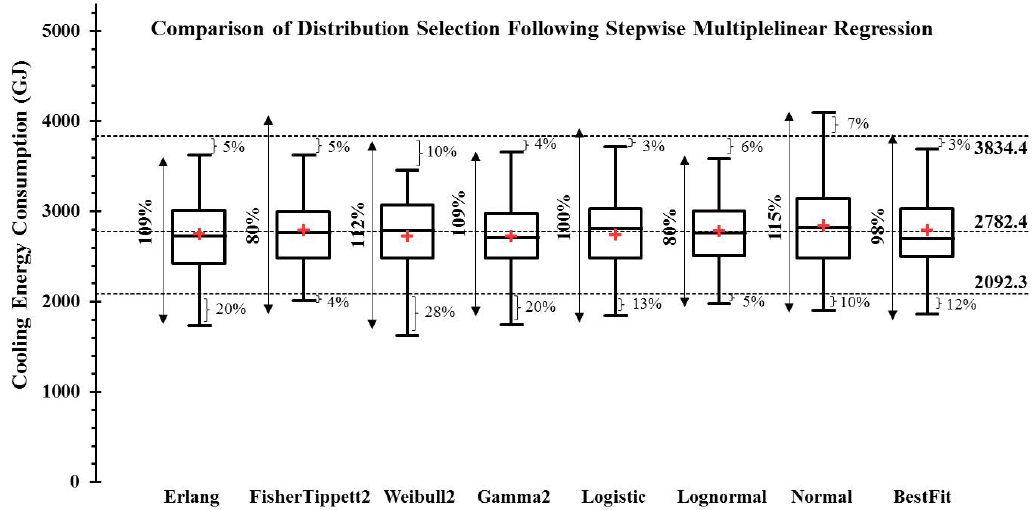
Figure 12. Cooling energy use probability density functions when following a stepwise multiple linear regression model and comparing selection of various input average annual weather variables distributions used in the uncertainty propagation